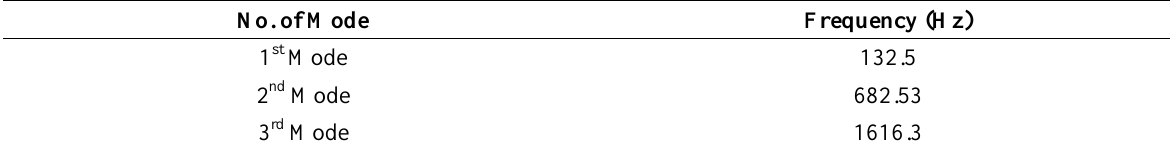
Table 1. Frequencies of cracked beam subjected to compressive load